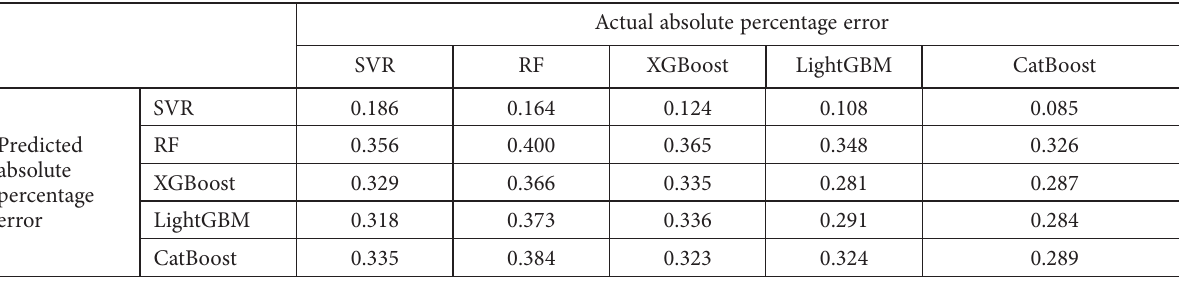
Table 8. Correlation coefficients of predicted and actual percentage